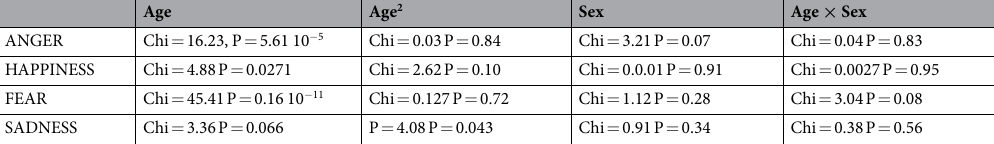
Table 1. Results from the mixed model logistic regression analyses for each emotion separately. The linear and quadratic effects of age, the effect of sex and interaction between age and sex effects are evaluated by comparing the fit of the logistic model with and without these factors 38 .